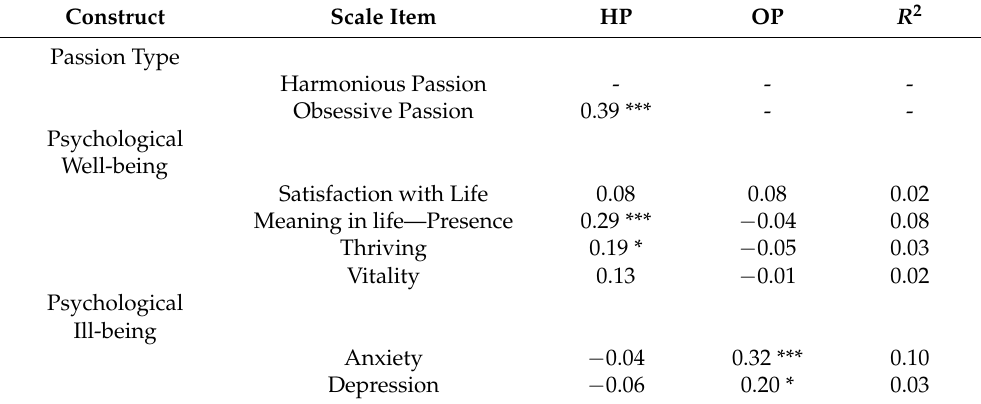
Table 2. Harmonious Passion and Obsessive Passion as Predictors of Measures of Well-Being